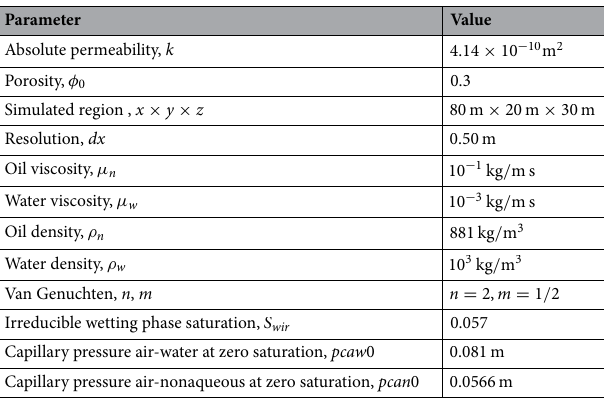
Table 2. Data used in the 3D transient three-phase fluid flow, with an LNAPL released in the unsaturated porous medium zone that goes downward directed to the saturated aquifer. Data results from numerical simulations using